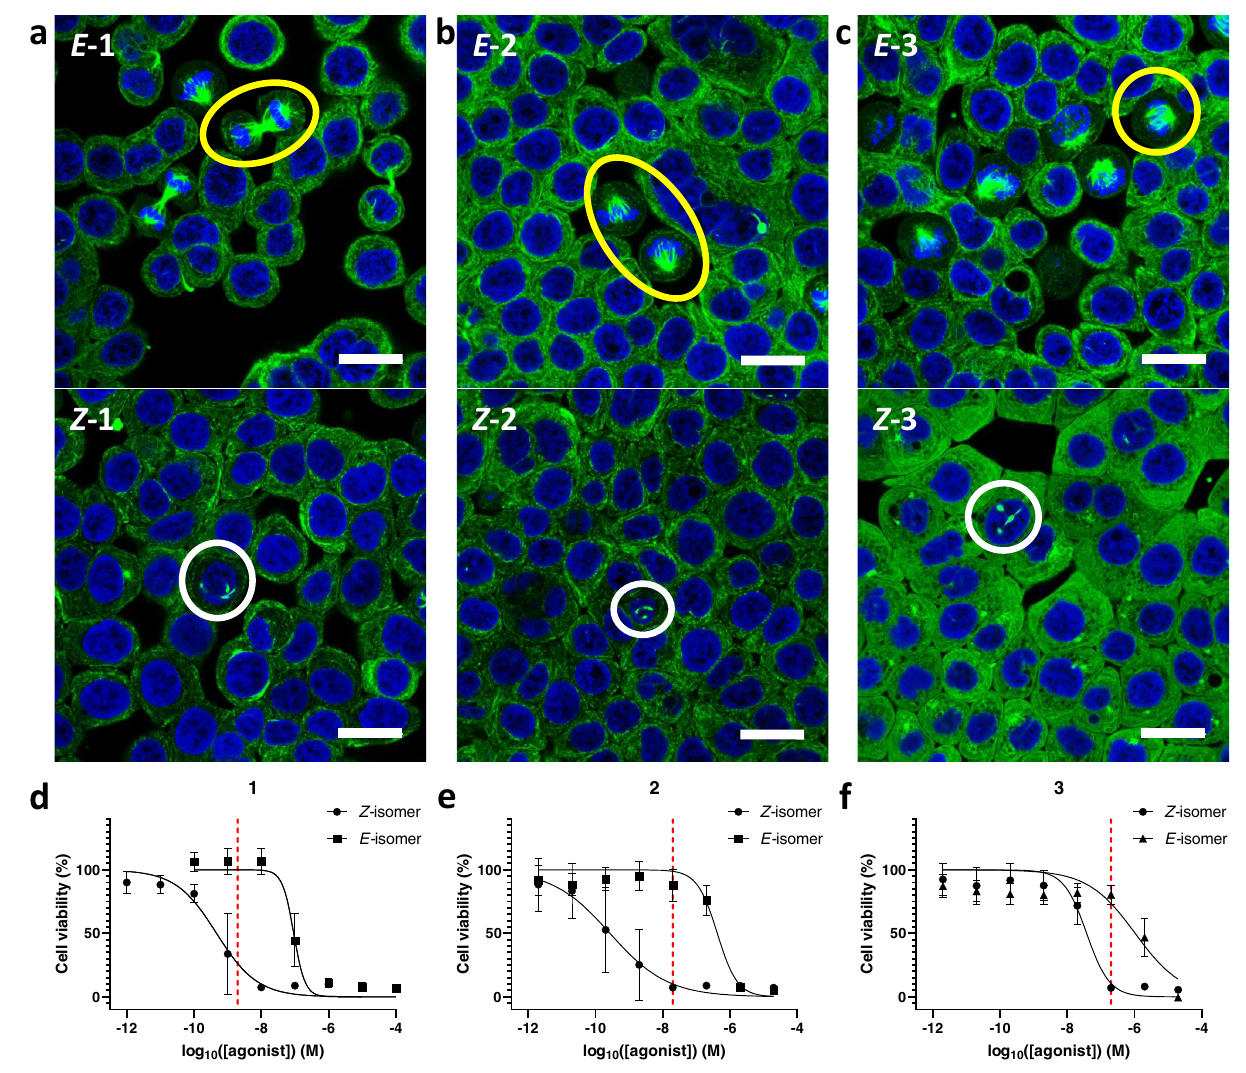
Fig. 2 | Immuno fl uorescence imaging. Immuno fl uorescence imaging of micro- tubule network structure in presence of the compounds 1 , 2 , and 3 . Confocal microscopy assessment of cellular microtubule networks after treatment with the respective photoisomersof a 1 (2nM), b 2 (20nM),and c 3 (200nM). (HT-29cells, 6h treatment, green: α -tubulin stain for microtubule polymer network, blue: DAPI nuclear counterstain, all scale bars 20 µ m). The results were processed and visua- lized with Leica Application Suite X 3.5.7.23225 from Leica Microsystems CMS GmbH. Correctly formedmitotic spindles are marked with yellow circles (the used concentrations of E -isomers are not cytotoxic) while white circles highlight